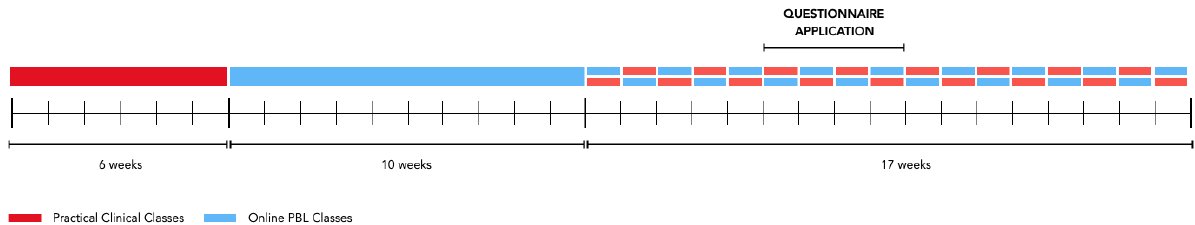
Figure 1. Dentistry Integrated Master Course final year schedule (33 weeks). Every space represents a week. Red boxes represent practical (presential) clinical classes. Blue boxes represent online problem-based learning (PBL) classes.